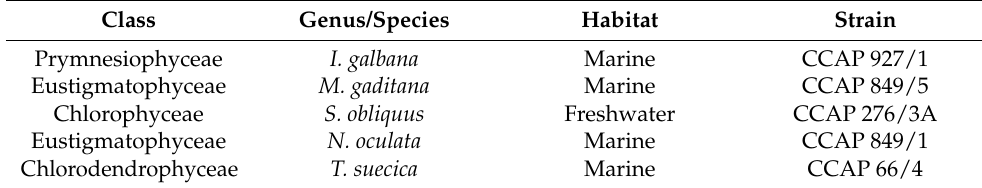
Table 1. Overview of the microalgae strains employed in the present